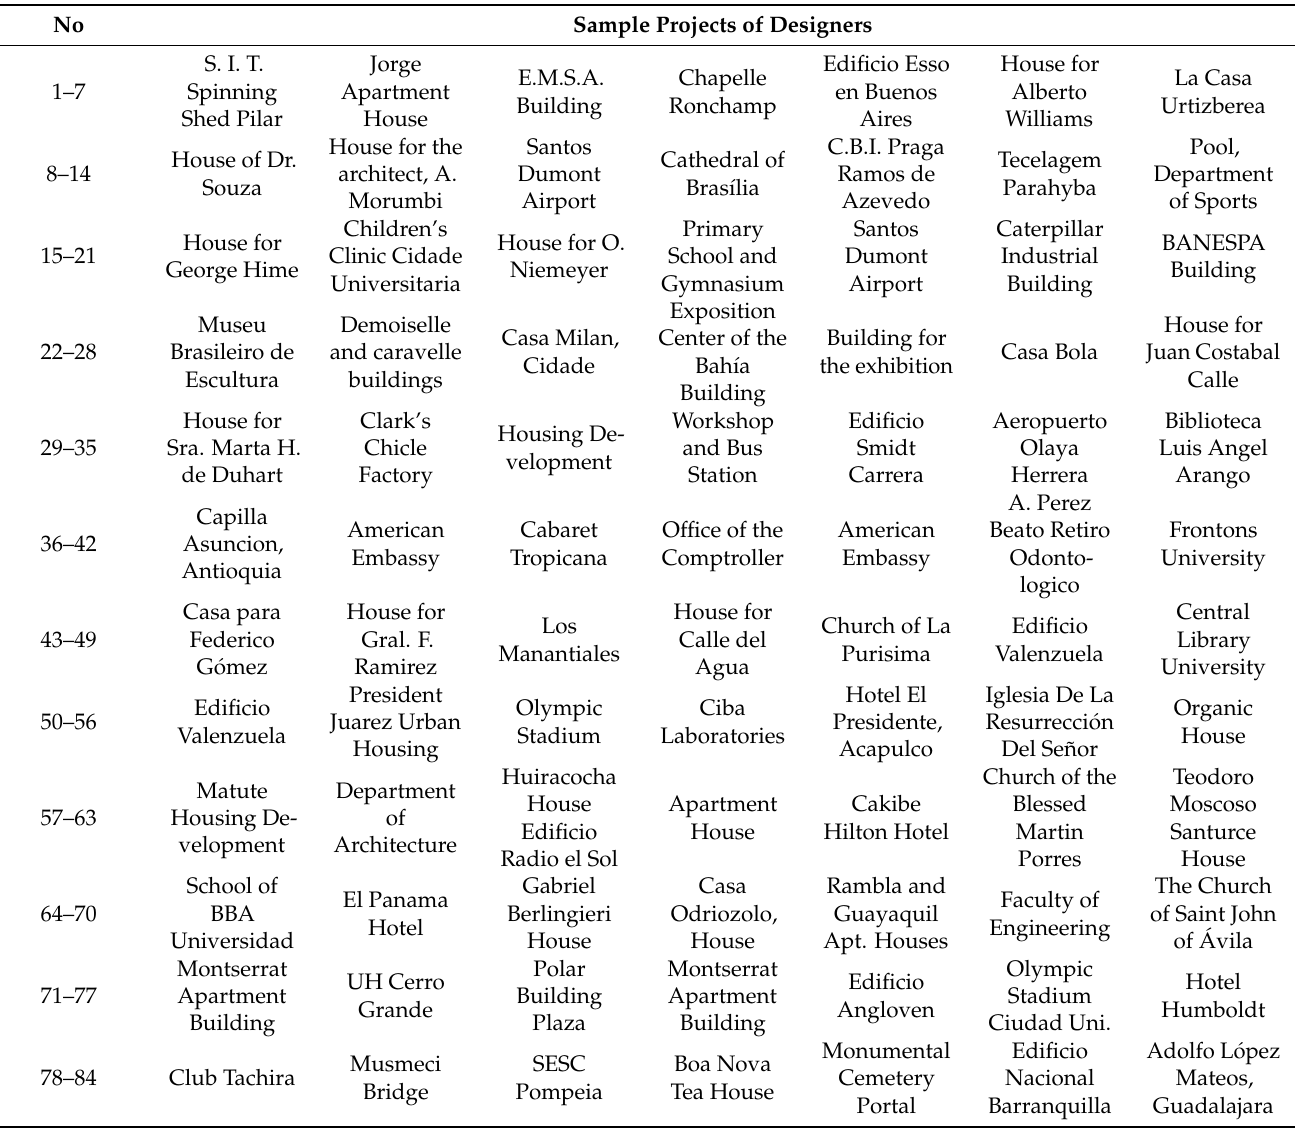
Table 3. Name list of the sample projects of